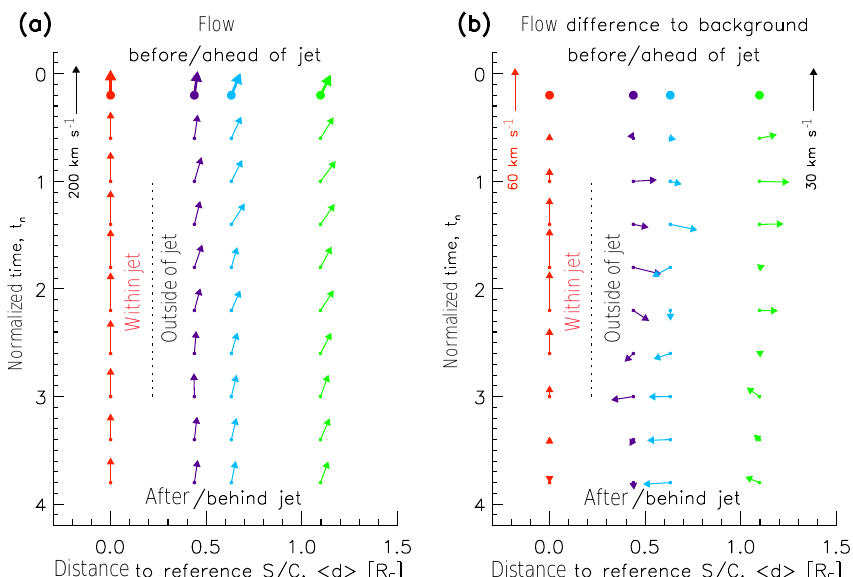
Figure 5. Visualization of velocities depicted in Fig. 4; cases where second spacecraft did not observe jets. Left panel (a) : arrows show median velocity components v (cid:107) (upwards) and (cid:49)v ⊥ (to the right) corresponding to different normalized times t n . Red arrows are based on reference spacecraft measurements. Purple, blue, and green arrows show median v (cid:107) and (cid:49)v ⊥ for the second spacecraft at three different distances (cid:104) d (cid:105) = 0 . 44 R E , (cid:104) d (cid:105) = 0 . 63 R E , and (cid:104) d (cid:105) = 1 . 10 R E . Initial values pertaining to normalized times t n = 0 ... 0 . 4 are depicted by bold arrows/circles. Right panel (b) : derived from (a) by subtracting those initial flow values, i.e., the respective background flows in the magnetosheath. Note that the arrow scales in panel (b) are different for reference and second spacecraft